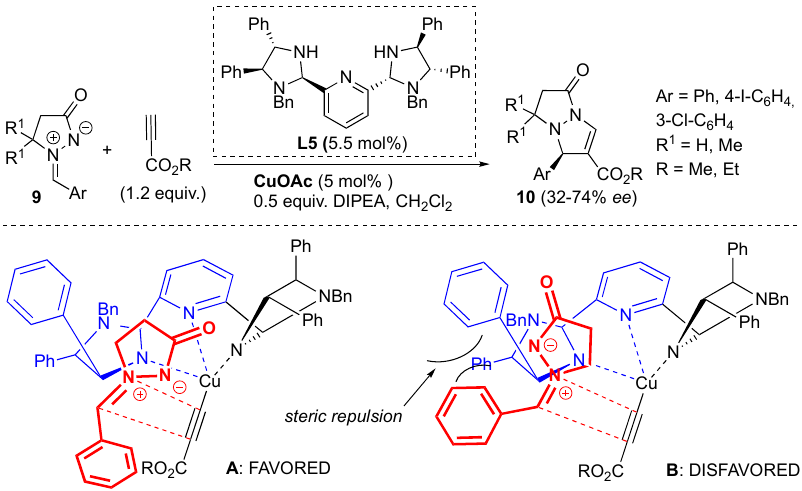
Scheme 3. Chiral Py-Bidine ligand in CuOAc-catalyzed cycloaddition of azomethine imines